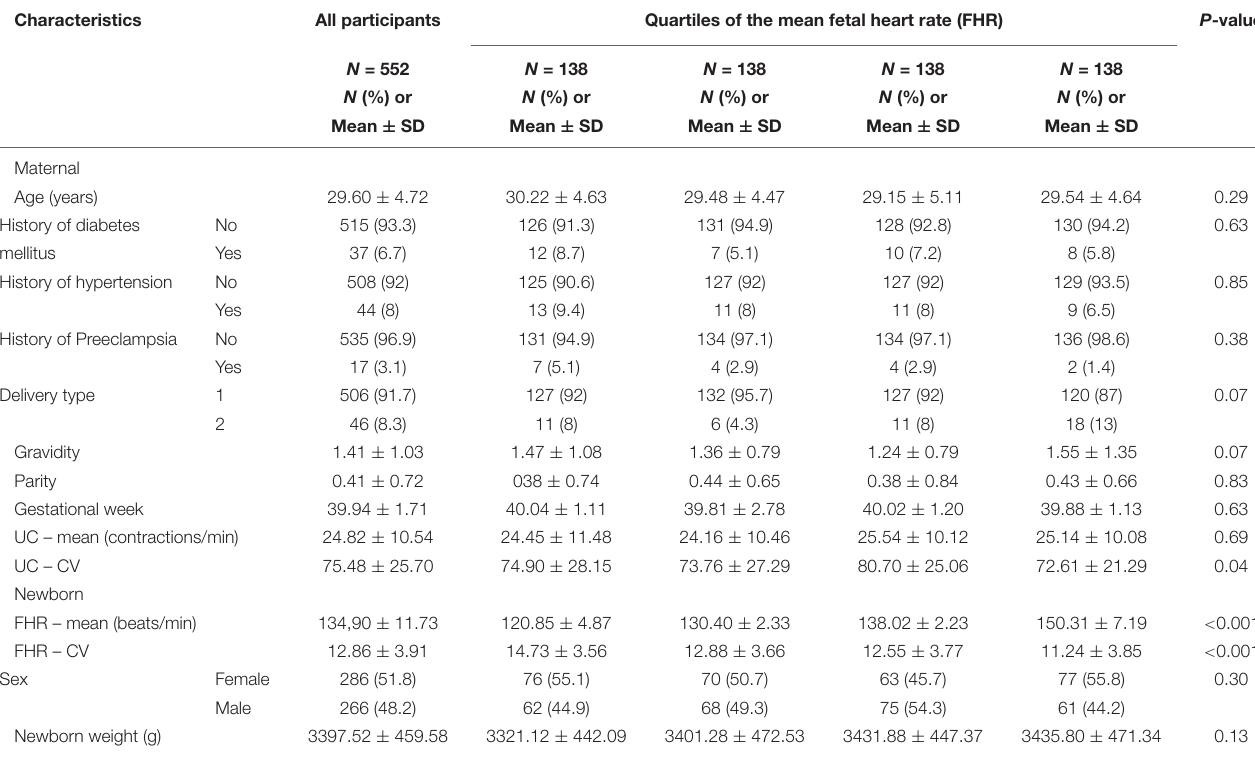
TABLE 1 | Characteristics of study participants by quartile of mean fetal heart